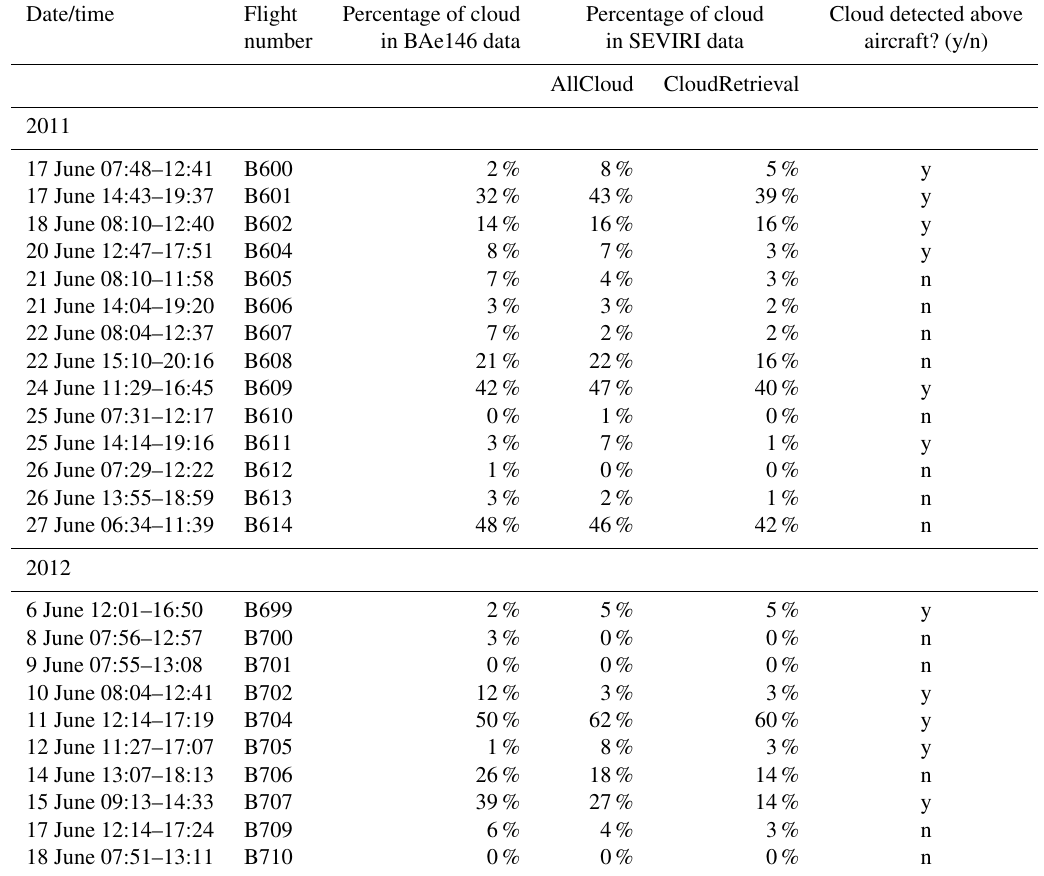
Table 1. Dates/times for each BAe146 flight, with the percentage of the dataset that is flagged as cloudy shown for the aircraft, the AllCloud SEVIRI mask, and the CloudRetrieval SEVIRI mask. Also shown is whether or not cloud above the aircraft was observed by the BBR. Date/time